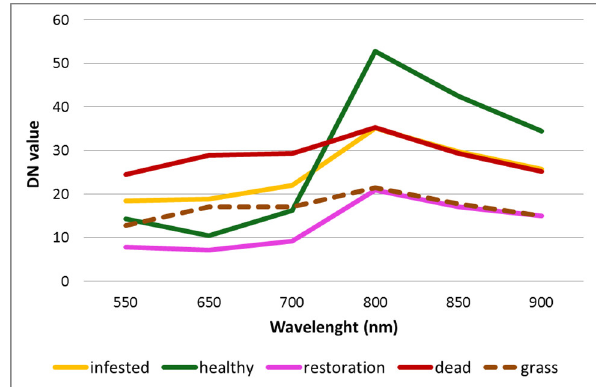
Figure 4. Average DN values of the established categories: infested trees, healthy trees, forest restoration, dead trees, and grass in the 550-900 nm spectral region.